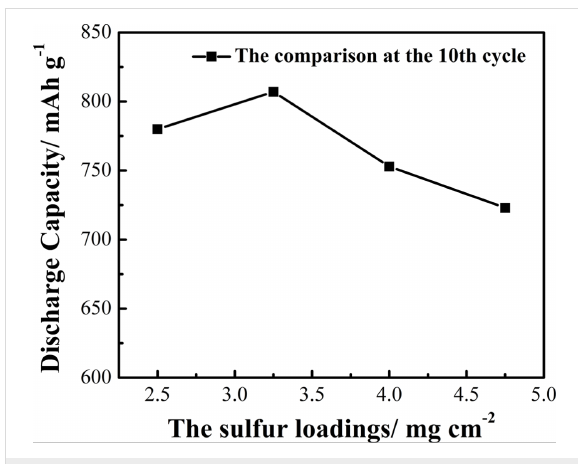
Figure 9: The performance comparison of S/ZnO@NCNT electrodes with sulfur loadings of 2.5, 3.25, 4.0 and 4.75 mg·cm − 2 at the 10th cycle at 0.2C.